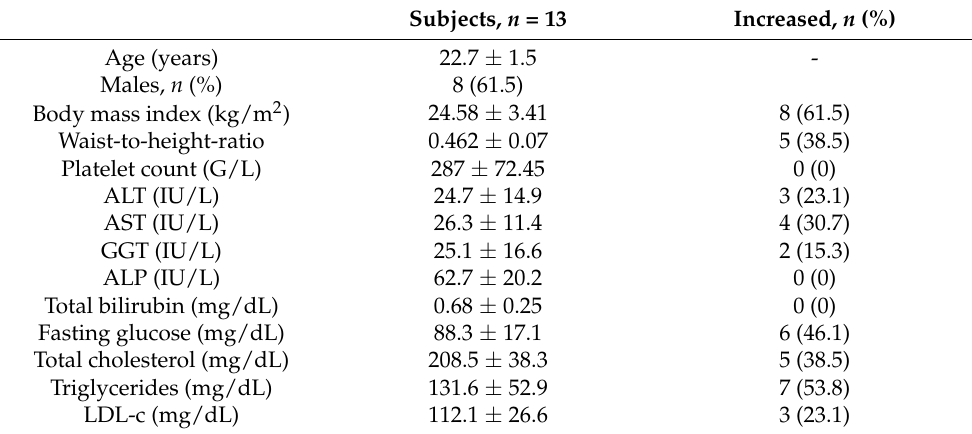
Table 2. Increased clinical and laboratory parameters in patients with liver fibrosis ≥